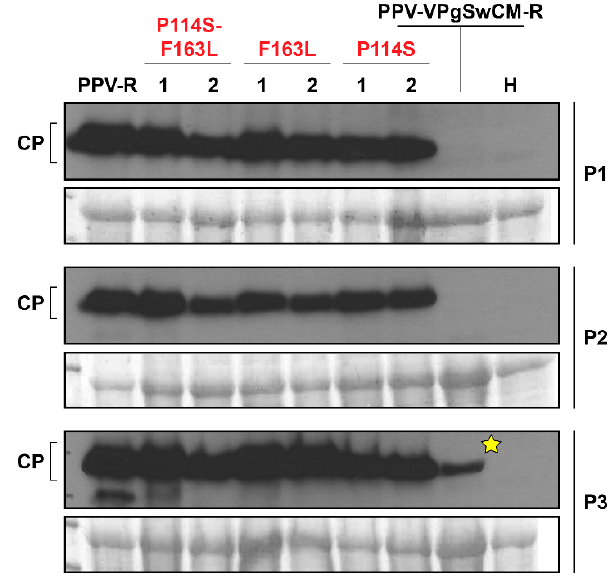
Figure 1. Effect of VPg mutations on A. thaliana infection by Plum pox virus (PPV). A. thaliana plants were inoculated by biolistic with the chimeric clone pICPPV-VPgSwCM-R, its indicated mutant variants (two independent clones, 1 and 2), or the PPV-R clone pICPPV-NK-lGFP. Extracts from upper non-inoculated leaves collected at 15 days after inoculation were subjected to CP-specific immunoblot analysis. Three individual plants (P1, P2 and P3), inoculated with the specified viruses, were analyzed. An extract of healthy plants (H) was used as a negative control. Blots stained with Ponceau red showing the large subunit of the ribulose-1,5-bisphosphate carboxylase-oxygenase (RuBisCO) are included as loading controls. The yellow star indicates that the progeny virus of this plant had incorporated a mutation in the VPg sequence (P114S).